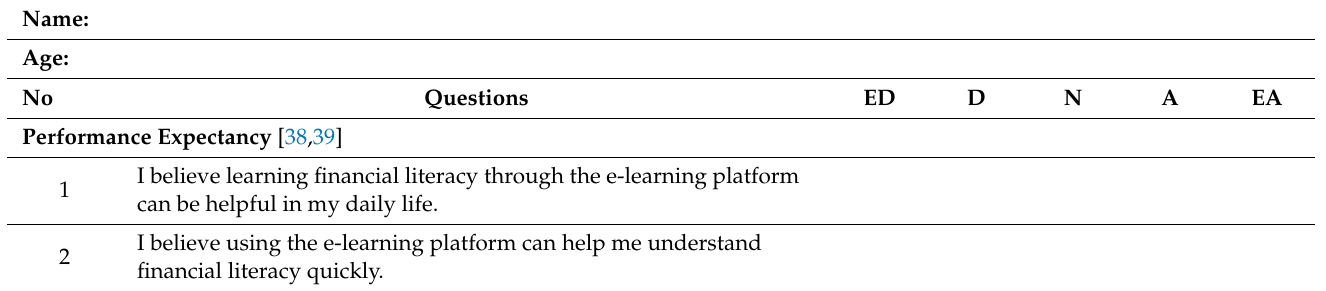
Table A2. Primary hypotheses questionnaire of